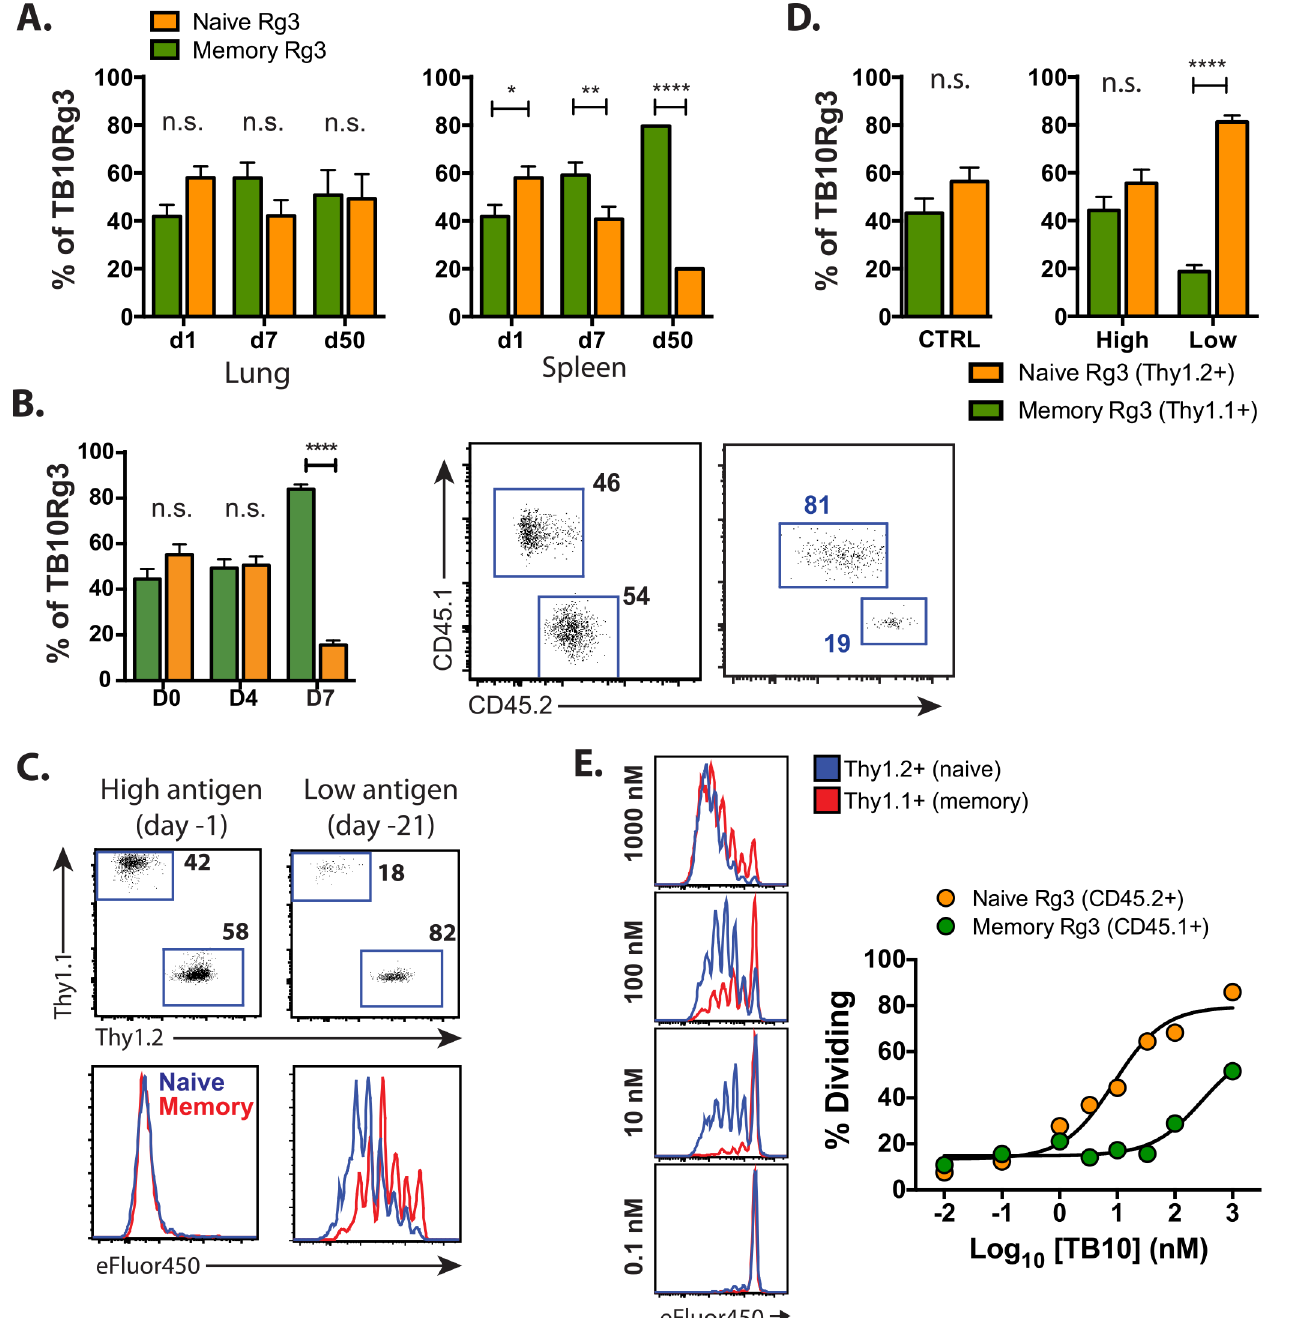
Fig 5. Memory CD8 + T cells proliferate but have a higher activation threshold than na ï ve CD8 + T cells. (a) The proportions of na ï ve and memory- derived TB10Rg3 cells in the lung (left) or spleen (right) 1, 7, or 50 d after adoptive co-transfer into mice administered amphi-TB10/poly(I:C)/CD40 1d prior to transfer. (b) Bar graphs (left) and representative flow plots (right) of the proportion of splenic TB10Rg3 CD8 + T cells (mean ± SEM) derived from memory (CD45.1 + ) or na ï ve (CD45.2 + ) TB10Rg3 0, 4, or 7 days after i.v. Lm Δ ActA-TB10 challenge of Thy1.1 + hosts, in which 10 4 memory and na ï ve TB10Rg3 cells were co-transferred at a 1:1 ratio 1 day prior to challenge. (c, d) The proportion of splenic TB10Rg3 cells (mean ± SEM) derived from na ï ve or memory TB10Rg3 3d after their co-transfer into mice administered amphi-TB10/poly(I:C)/CD40 1d (high antigen) or 21d (low antigen) prior to transfer. Their ratios and dilution of proliferation dye are shown. (e) eFluor450 dilution by na ï ve or memory TB10Rg3 cells 64h after culture with peptide-coated splenocytes (left) and summary of dose-response data (right). Memory: na ï ve T cell ratios across time points were compared by a 2-way ANOVA and the Bonferroni post-test. * p < 0.05, ** p < 0.01, **** p < 0.0001, n.s. not significant. Data are representative of 2 – 3 independent experiments, each with 3 – 4 mice per time